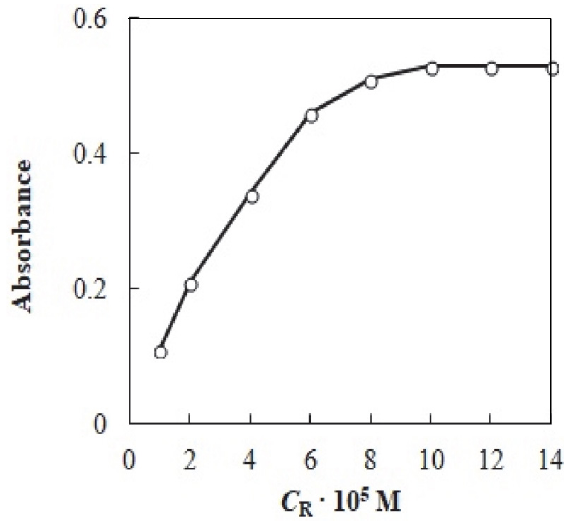
Fig. 5. The effect of the concentration of DHDPhB on the extraction of 5 × 10 –7 mol/dm 3 of Cu(II), V Chloroform = 1 cm 3 , V Methanol = 1 cm 3 , λ = 570 nm.